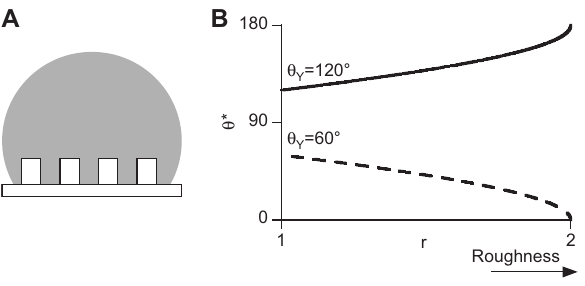
Figure 2 (A) The Wenzel scenario where a water drop follows the roughness of the underlying substrate – homogeneous wetting regime. (B) Apparent contact angle, θ *, as a function of the = 60 ° ) and roughness factor r for an inherent hydrophilic (with θ Y = 120 ° ) material, according to the Wenzel hydrophobic (with θ Y equation, Eq.